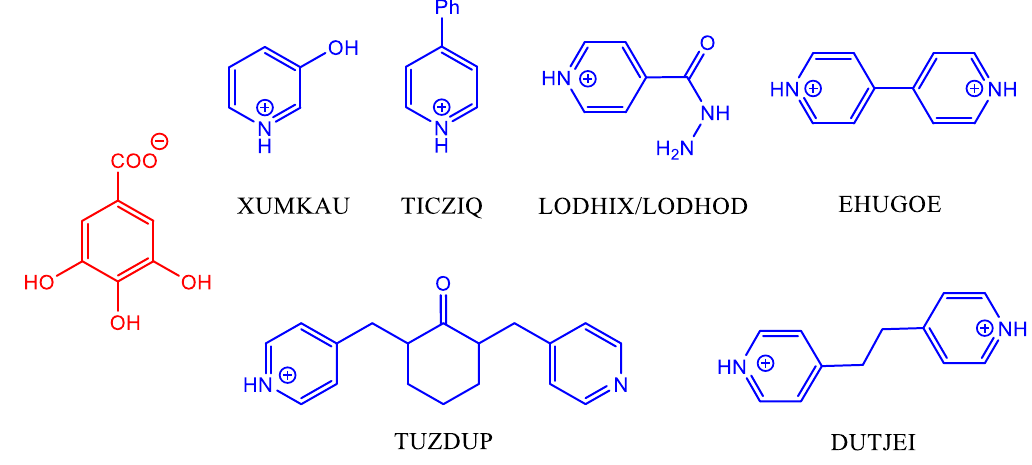
Table 3. Contributions (%) of various interactions into the Hirshfeld surface of the gallate anion in 4 and 5 .